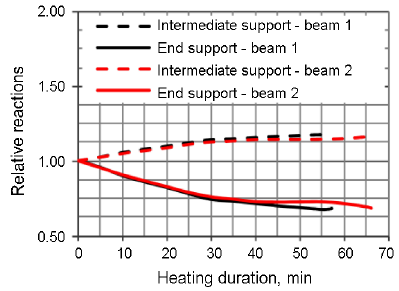
Fig. 6. Relative changes of support reactions: intermediate and end support